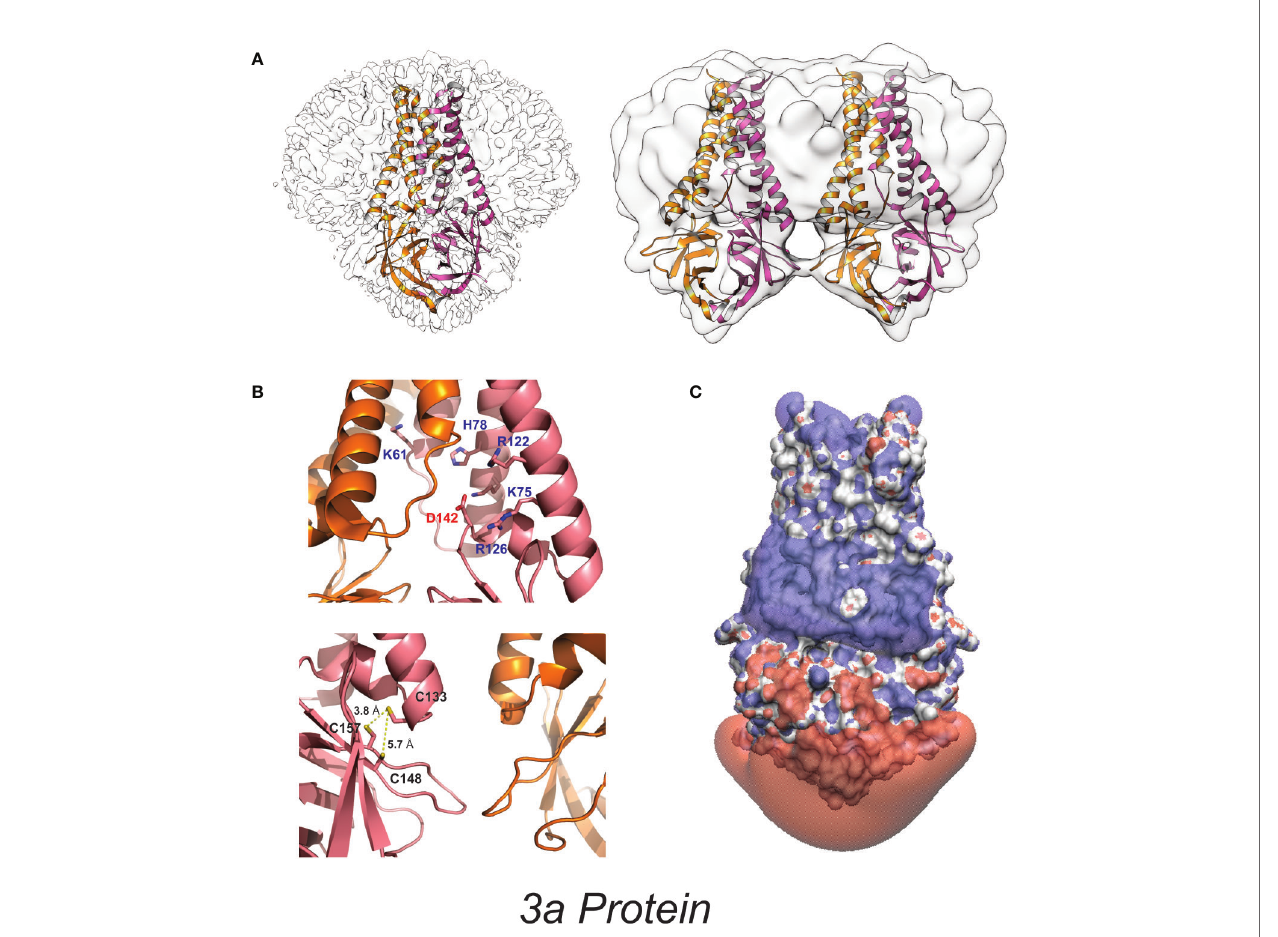
FIGURE 3 | High-resolution 3a protein structure (A) Model of 3a dimer (left) and dimer-of-dimer (right) proteins embedded in lipid nanodiscs (PDB: 6XDC) (41). (B) (above) Location of charged residues within the cavity. ( below ) Location of cysteine residues near the dimer-dimer interface. (C) Space- fi lling model colored to illustrate the isoelectric potential of the dimeric protein (+3 blue and − 3 red) computed by PDB2PQR (42) and APBS (43) webservers with default